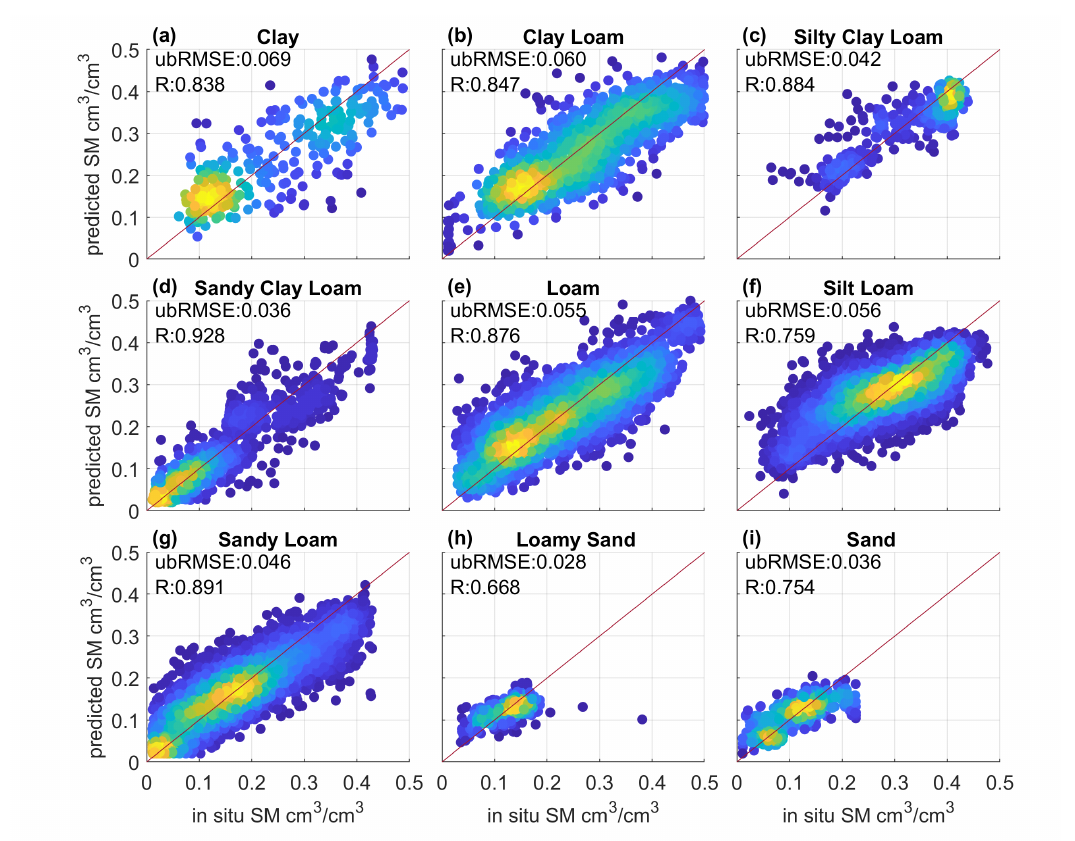
Figure 8. Scatter plots of SM retrievals for different types of soil